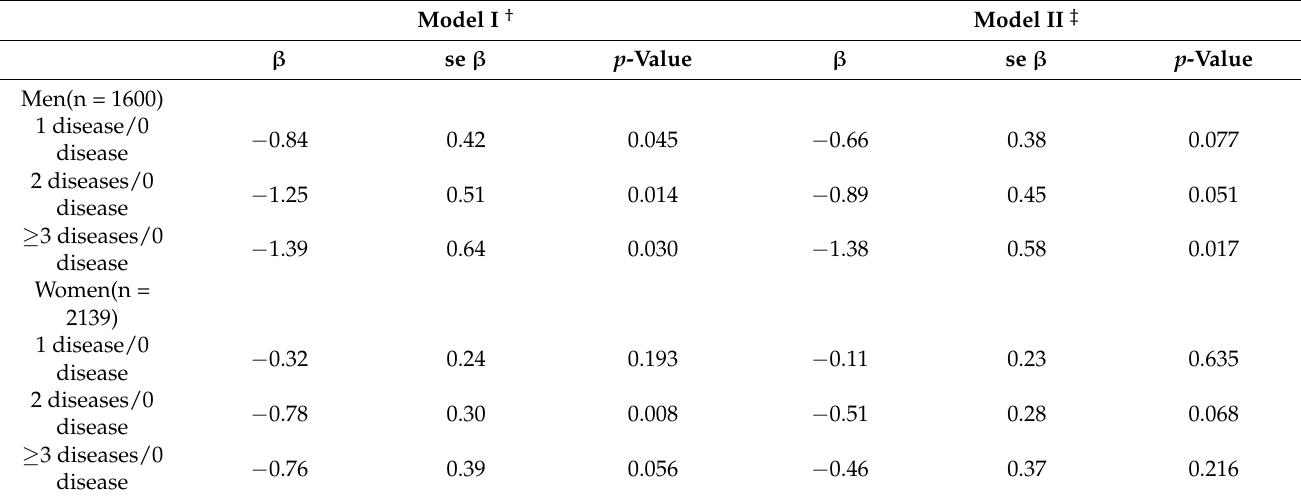
Table 4. Multivariate regression coefficients of grip strength on chronic disease status before and after adjusting for confounding variables with sex specifications. Model I † Model II ‡ β se β p